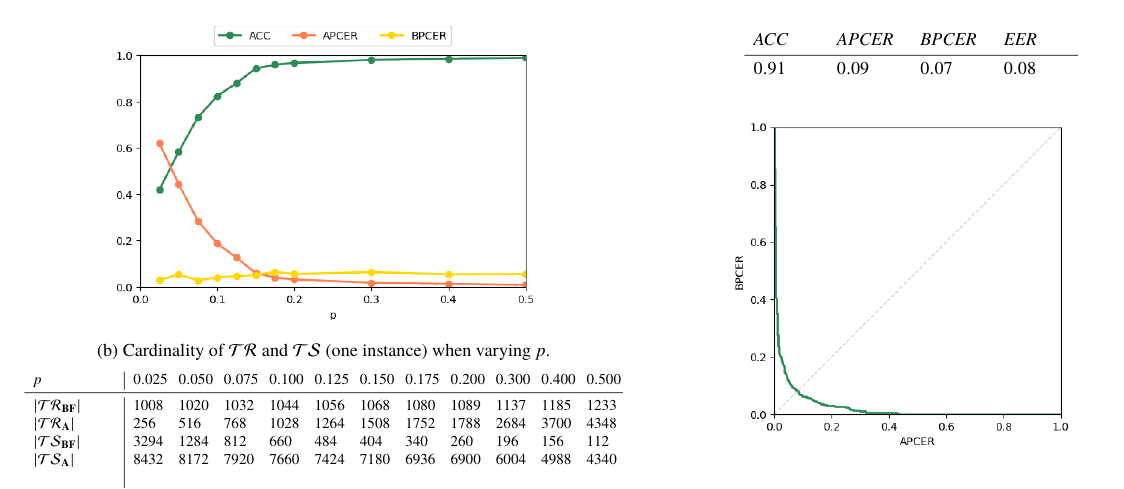
Figure 6. Results for the AMSL -only scenario.